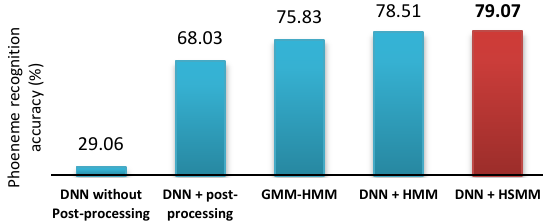
Figure 9. Results of phoneme recognition accuracy using three methods to generate phoneme sequence (post- processing, HMM and HSMM) in DNN-based phoneme recognition, and comparing their results with GMM- HMM baseline